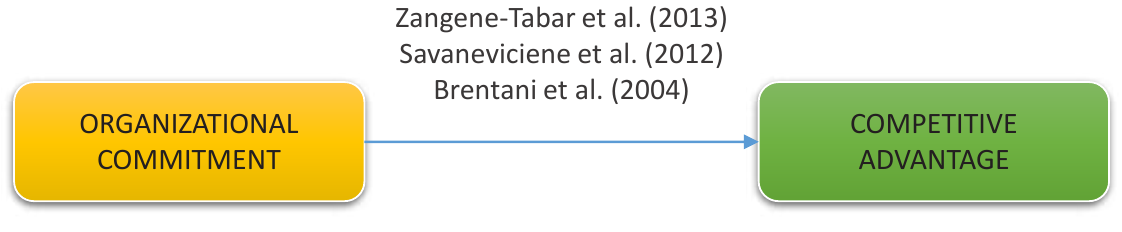
Figure 4. Organizational commitment relationship toward competitive advantage